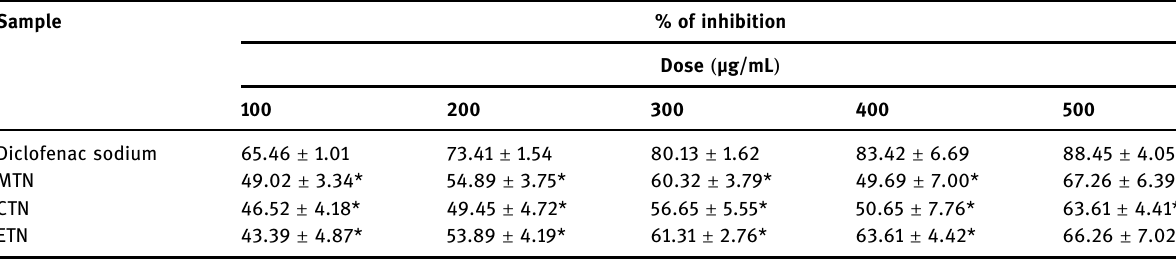
Table 3: Anti - arthritic activity of T. nudi fl ora leaf extracts at di ff erent doses Sample % of inhibition